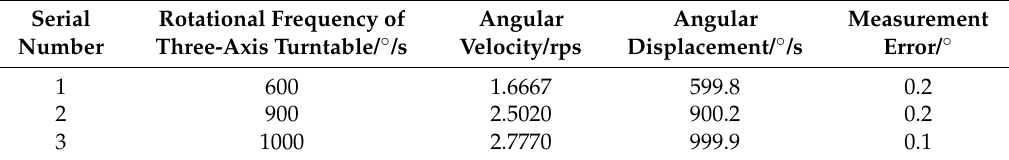
Table 4. Experimental test results of three-axis flight turntable.